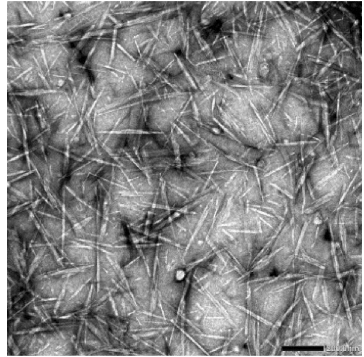
Figure 2. Needle shaped chitin nanocrystals derived after acid hydrolysis observed with transmission electron microscopy. The scale bar has a size of 200 nm.